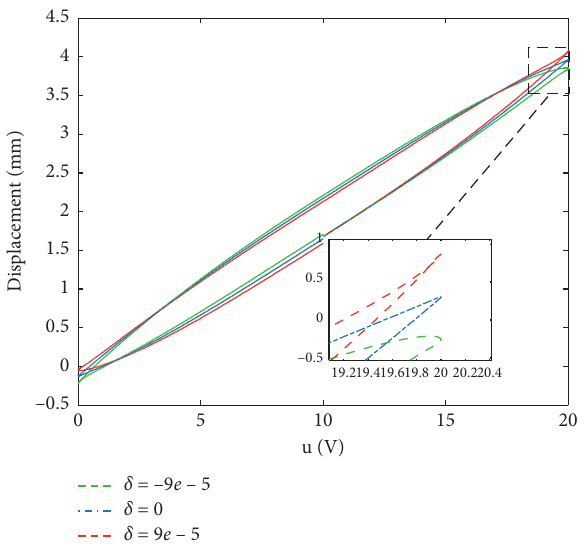
Figure 1: Asymmetric hysteresis curves with different δ